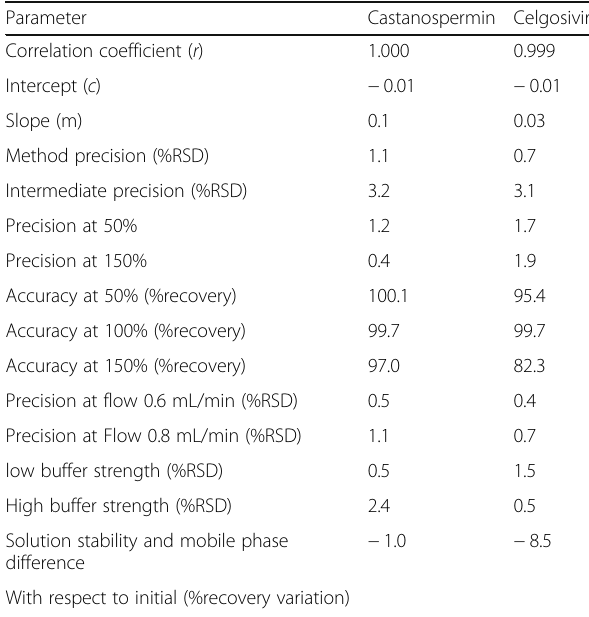
Table 4 Summary of validation results